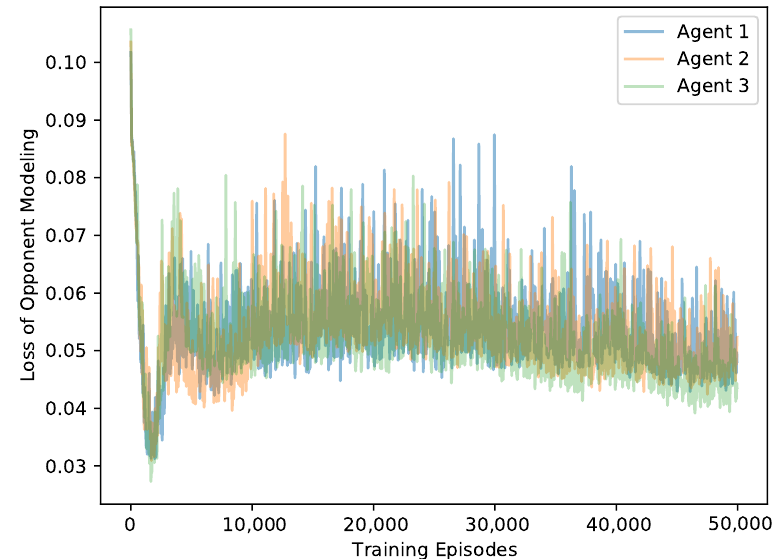
Figure 8. The loss curves of opponent models on Cooperative Navigation.